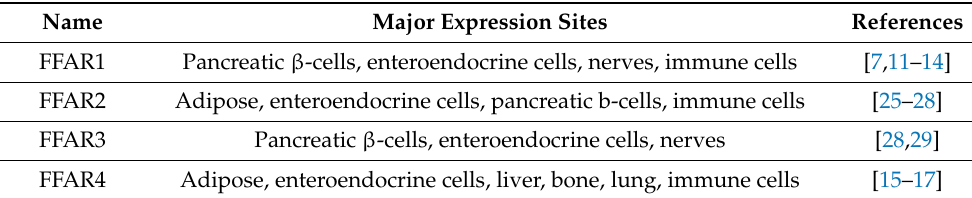
Table 1. List of FFAR isoforms and their tissue